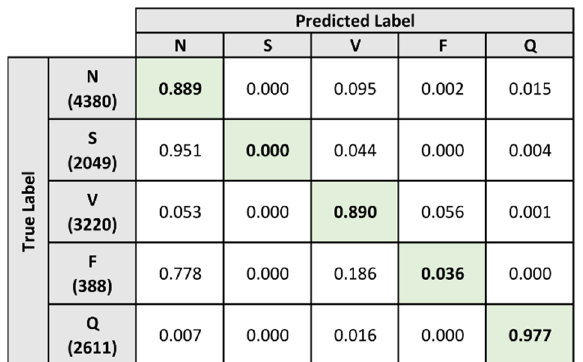
Figure 12. Normalized confusion matrix of baseline heartbeat classification on test dataset.